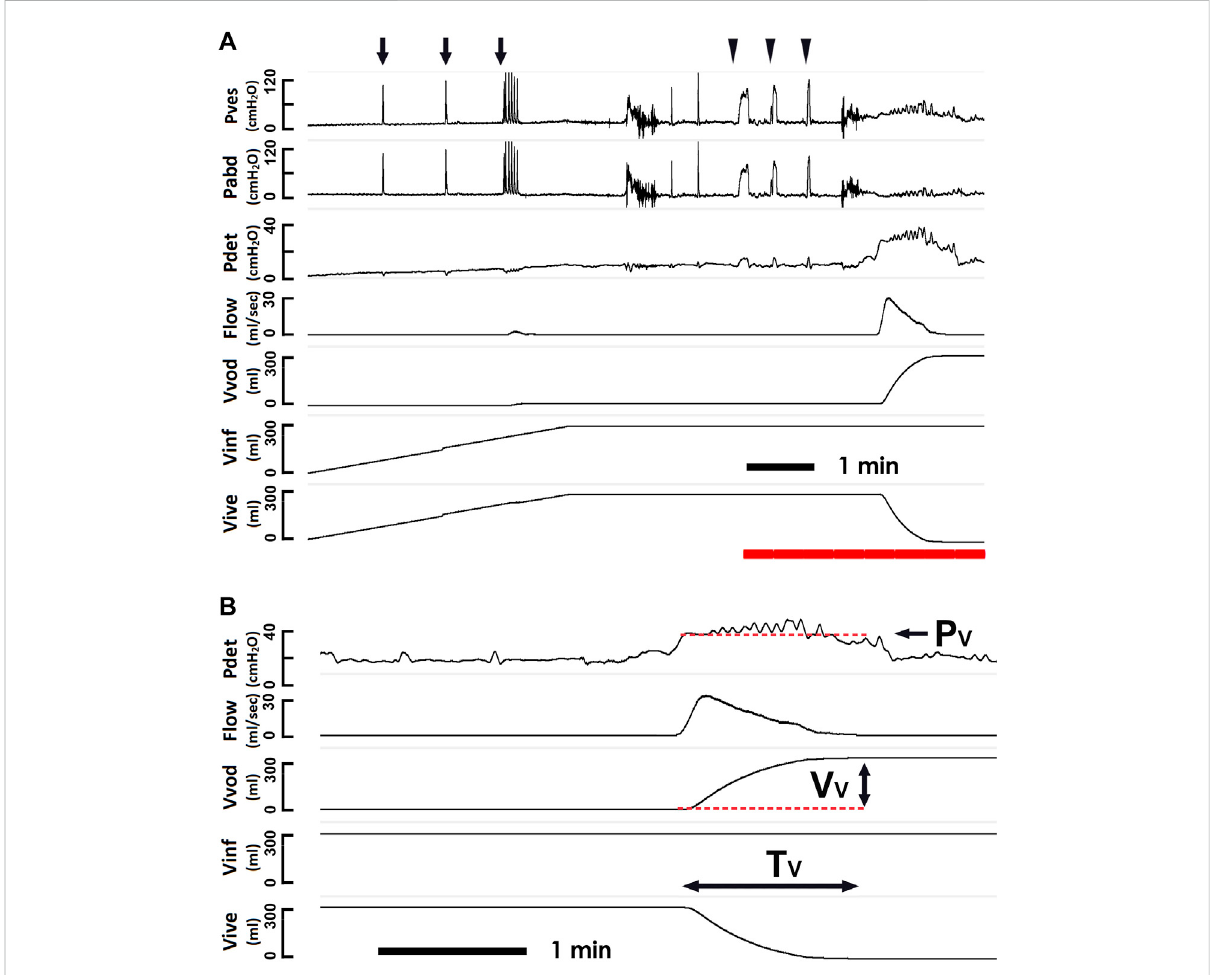
FIGURE 1 Pressure- fl ow study and derived voiding parameters. (A) representative cystometry tracings showing the vesical pressure (Pves), abdominal pressure(Pabd),detrusorpressure(Pdet),urethral fl ow(Flow),voidedvolume(Vvod),infusedvolume(Vinf),andintra-vesicalvolume(Vive).Although, coughs (arrows) and Valsalva maneuvers (triangles) induce marked fl uctuations in the Pves and Pabd, they exhibit low effect on the Pdet. The Pdet, Flow, Vvod, Vinf, and Vive marked by the red bar at the bottom are showed using a faster time-base below. (B) derived voiding parameters including the mean voiding pressure (Pv), the voided volume (Vv), and the voiding time